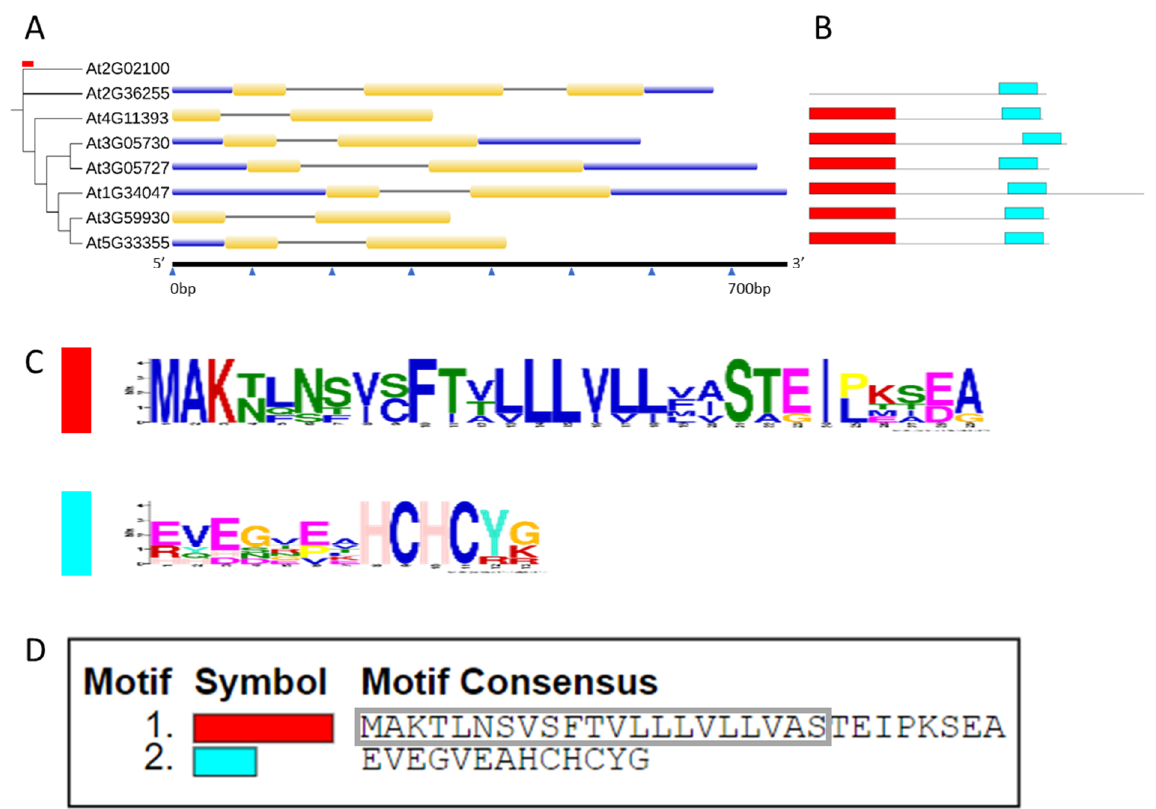
Figure 4. Comparison of Arabidopsis CRP0770 genes. ( A ), Phylogenetic tree and gene structure. The maximum likelihood (ML) tree was generated by the WAG + G4 model using ultrafast bootstrap with 1000 replicates in iQ-Tree web server. At2g02100 (a plant defensin gene) was included as an out group. The red bar on the tree shows tree scale = 0.1. Exons are shown in yellow and black lines indicate introns. UTRs (5′and 3′ untranslated regions) are shown in blue. ( B – D ), Conserved motif analysis. ( B ), the motifs are represented with different colors, motif 1 red and motif 2 aqua blue. ( C ), sequence logos of the motifs. Conserved motif analysis found 2 motifs. Motif 1 consisted of the signal peptide and the beginning of the mature peptide. Motif 2 contained the last 2 cysteines. ( D ), consensus sequence for both motifs. Motif 1 contains the signal peptide (indicated by a grey box). Motif 2 is conserved in all genes, while motif 1 is missing in At2g36255